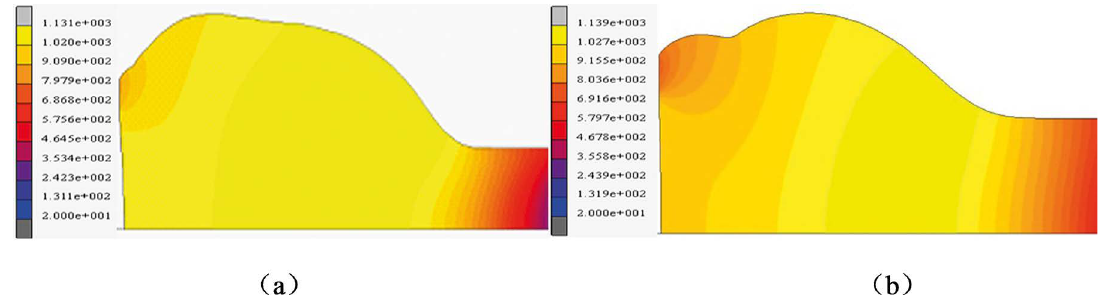
Figure 12: The forming results in numerical simulation: (a) under the three-stage current mode, (b) under the constant current